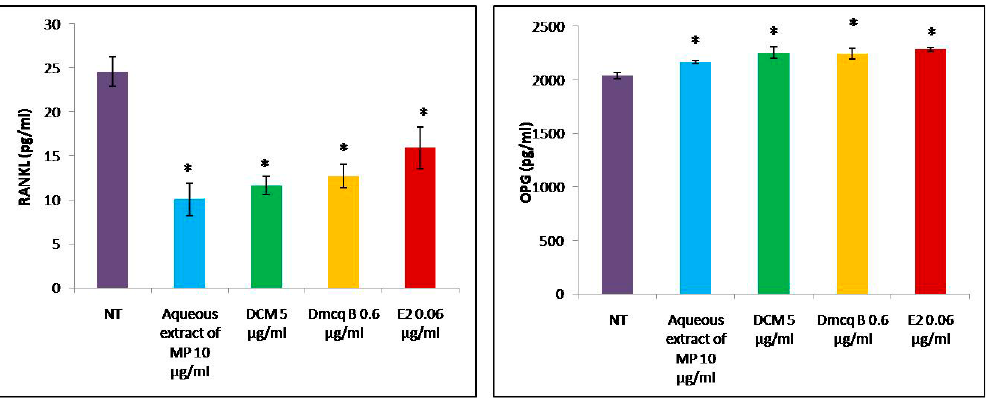
Figure 10. Effects of M. pumilum var. alata crude aqueous extract, DCM fraction, Dmcq B and E2 (positive control) on RANKL/OPG ratio. All M. pumilum var. alata treatments showed significantly lower RANKL protein expression followed by an increment of OPG protein expression, hence the RANKL/OPG ratio was decreased for all the treatments, resembling the effects of E2 treatment. The data are presented as means of percentage of treatment ± SEM; n = 6. * Significantly different ( p < 0.05) compared to NT group. NT non-treated group MP M. pumilum var. alata crude aqueous extract DCM dichloromethane fraction of crude aqueous extract Dmcq B demethylbelamcandaquinone B. 2.7. Effects of Crude Extract, DCM Fraction and Dmcq B on ER Protein Expression As a positive control, E2 increased ER α and ER β protein expressions in osteoblasts (Figure 11). This study showed that the M. pumilum var. alata crude aqueous extract and DCM fraction of crude aqueous extract were at par with E2 results in inductions of both ER α and ER β protein expressions. Its active compound, Dmcq B only led to an increase of ER β protein expression and there was no effect on ER α protein expression when compared to non-treated group. As a novel phytoestrogen isolated from M. pumilum var. alata , it can be reasonably speculated that Dmcq B would stimulate osteogenic effects through ER β signaling.